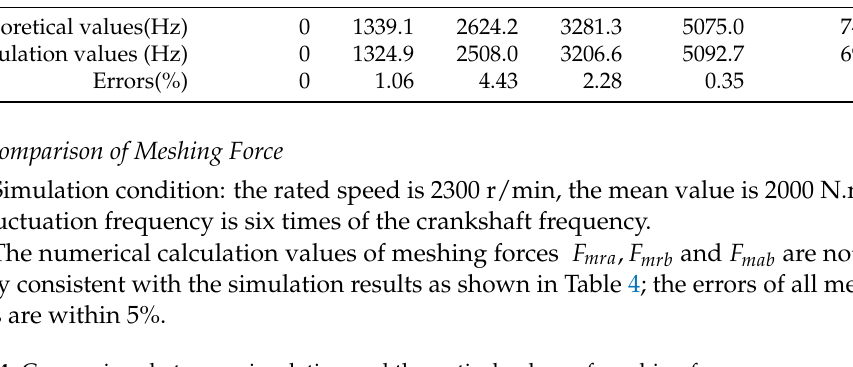
Table 4. Comparison between simulation and theoretical values of meshing